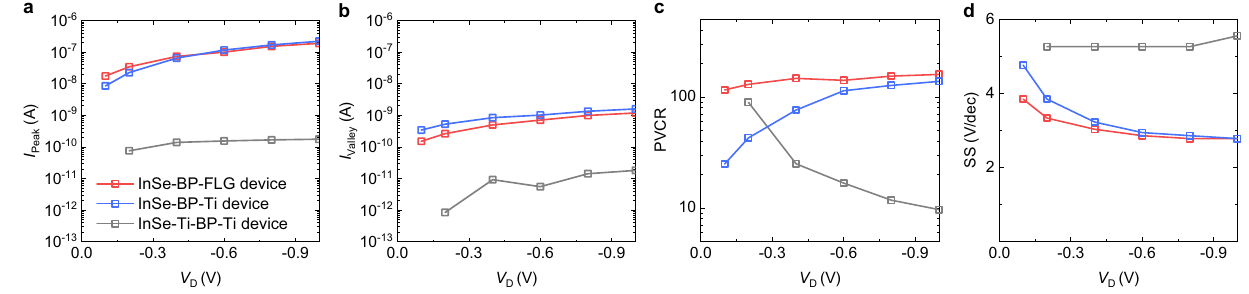
Figure 5. ( a ) I Peak , ( b ) I Valley , ( c ) PVCR, and ( d ) SS of the InSe-Ti-BP-Ti (grey), InSe-BP-Ti (blue), and InSe-BP- FLG (red) devices as a function of using the ρ InSe at V BG = 0 V (data in Fig. 1e) and the dimension of the InSe region between the two inner contacts, without taking into account any of the BP region and the InSe/BP junction resistance. This suggests that the current flows mostly along the InSe, and the heterojunction resistance and FLG contact resistances are negligible compared to the InSe channel resistance. We thus neglect the InSe/BP junction resistance when considering the equivalent circuits of the InSe-BP-Ti device in Fig. 2. The low InSe/BP junction resistance even when the BP is p -type (at V BG < 0) and V D < 0 is due to BTBT between the InSe and BP, as described in the band diagram in Fig. 3e. The output characteristics of the individual InSe and BP regions with FLG contacts also reveal ohmic characteristics (Figure S6), which contrasts with the Schottky behavior of Au/Ti contacts on the InSe. This leads to the transconductance behavior being nearly the same regardless of the polarity of V D (Figure S7), distinct from the InSe-BP-Ti device. The schematic in Fig. 4e describes the InSe-Ti-BP-Ti device where InSe and BP are serially connected via Au/Ti contacts and the associated measurement setup. Figure 4f shows the G 2pt InSe−BP measured from the InSe- Ti-BP-Ti device as a function of V BG at different V D , ranging from -0.1 to -1 V. The NDT characteristics are also observed in this device, similar to the InSe-BP-Ti device and InSe-BP-FLG device. This further reveals that the NDT behavior originates from the individual InSe and BP parts rather than the vertically overlapped InSe/BP region. The measured G 2pt InSe−BP agrees well with (( G 2pt InSe ) −1 + ( G 2pt BP ) −1 ) −1 (dashed line in Fig. 4f). However, we note the much lower G peak (~0.1 nS), compared to those of the InSe-BP-Ti device and the InSe-BP-FLG device (>0.1 μS). This is due to the additional Au/Ti contact resistances that exist between the InSe and BP, which are much larger than the InSe/BP vdW junction resistance. The thicknesses of the BP and InSe flakes in the InSe- Ti-BP-Ti device were 3 nm and 9 nm, respectively (Figure S8). Figure 5a,b show the peak current ( I Peak ) and valley current ( I Valley ) of the InSe-BP-Ti, InSe-BP-FLG, and InSe- Ti-BP-Ti devices as a function of V D from −0.1 to −1 V. Both I Peak and I Valley values of the InSe-Ti-BP-Ti device are far lower than those of the InSe-BP-Ti and InSe-BP-FLG devices. As mentioned above, this is attributed to the additional R C InSe and R C BP from the Au/Ti contacts between the InSe and BP. Figure 5c,d show the extracted PVCR and subthreshold swing (SS) values of the devices, respectively. While the PVCR of the InSe-BP-Ti device increases as the V D increases, the PVCR of the InSe-BP-FLG device weakly depends on V D . In the InSe-BP-Ti device, as V D increases, R C BP decreases; thus, the PVCR increases and the SS decreases. By contrast, the low FLG contact resistance in the InSe-BP-FLG device leads to the PVCR and SS being less dependent on V D . The transfer characteristics of the InSe-Ti-BP-Ti, InSe-BP-Ti, and InSe-BP-FLG devices can be compared to those calculated as ( R InSe + R C InSe + R BP + R C BP ) −1 , ( R InSe + R BP + R C BP ) −1 , and ( R InSe + R BP ) −1 , respectively (Fig. 2a). The calculated conductances at their NDT valley points are similar (Fig. 2e), regardless of the inclusion of R C InSe or R C BP . This is because the valley point characteristic is dominated by the large R BP at the charge neutrality of BP. On the other hand, the conductance at the NDT peak strongly depends on whether R CInSe or R CBP is included. The additional R CInSe and R CBP existing in the InSe-Ti-BP-Ti device result in much lower PVCR and worse SS values due to reduced gate control. By contrast, the negligible vdW junction resistance renders better PVCR and SS values for the InSe/BP vdW heterostructure devices. In many cases, ohmic contacts are more favorable than Schottky contacts. Our InSe-BP-FLG device also shows I Peak and PVCR values higher than those of InSe-BP-Ti device (Fig. 5). The ohmic symmetric contacts in InSe-BP-FLG device lead to the nearly the same NDT characteristics for both positive and negative V D regimes (Figure S7). On the other hand, the asymmetric Au/Ti contacts to the InSe and BP in InSe-BP-Ti device can provide dissimilar operational properties depending on the polarity of V D , multi-valued transistor behavior at V D > 0 and NDT at V D < 0. Particularly at V D > 0, the high Schottky barrier (contact resistance) at the junction between Au/Ti contact and InSe becomes highly effective (point (i) in Fig. 3). This suppresses the current in that regime, leading to the intermediate state for the multi-valued transistor instead of a NDT peak (Figs. 2, 3, and Figure S2). Our study as a function of multiple device parameters, including contact type and heterojunction type, can provides an idea for fine manipulation of electronic device characteristics. In addition, we investigated the impact of BP thickness ( t BP ) on the electrical characteristics of our InSe-BP-Ti devices. Figure 6a shows the I D of two InSe-BP-Ti devices (solid) with different t BP , 4 nm and 14 nm, as a func- tion of V BG , shifted with respect to the V BG at the minimum I D of the BP. The most salient feature here is that the device with thinner BP shows significantly reduced I Valley , resulting in a highly improved PVCR. The transfer curve of the BP side of each InSe-BP-Ti device is also provided for comparison (dashed). The on/off current ratio of the 4 nm-thick BP is much higher than that of the 14 nm-thick BP due to the increased band gap, as